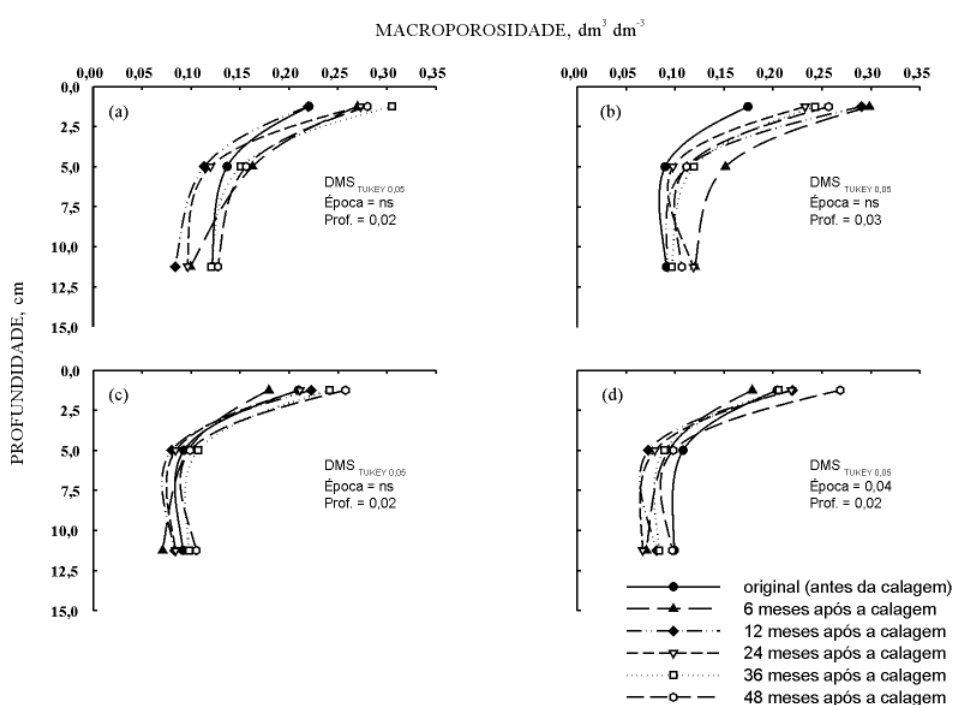
Figura 3. Macroporosidade do solo em diferentes épocas de avaliação, profundidades e sistemas de manejo. (a) convencional durante 12 anos; (b) semeadura direta com revolvimento do solo a cada quatro anos; (c) semeadura direta durante oito anos; (d) semeadura direta durante 12 anos.